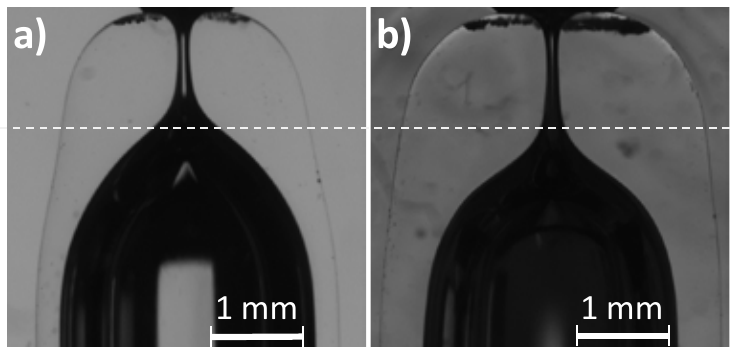
Figure 10. Nozzles of D ≈ 130 µ m manufactured from capillaries of the same inner diameter and different wall thicknesses. ( a ) Capillary type 1, r = 3.5 mm, t = 150 s, ∆ L = 1.47 mm. ( b ) Capillary type 2, r = 3.5 mm, t = 520 s, ∆ L = 1.13 mm. The line is to guide the eye.